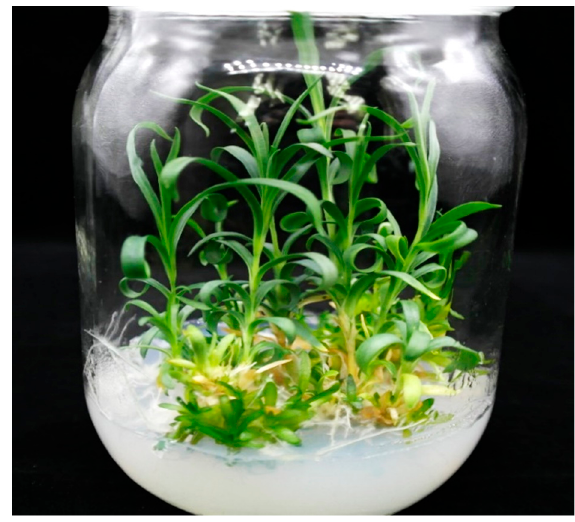
Figure 4. Conversion of vitrified plants to normal plants on the rooting and plant growth medium containing 1% plant agar.